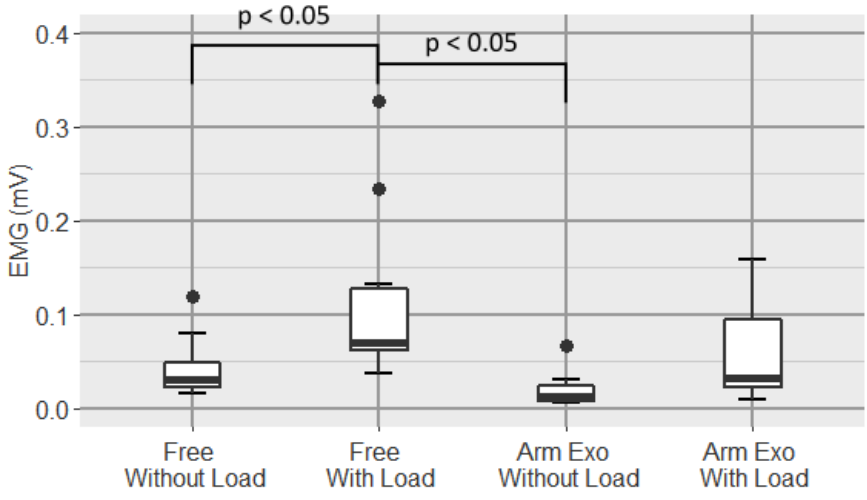
Figure 11. Boxplot of the EMG signal of the biceps for all conditions.